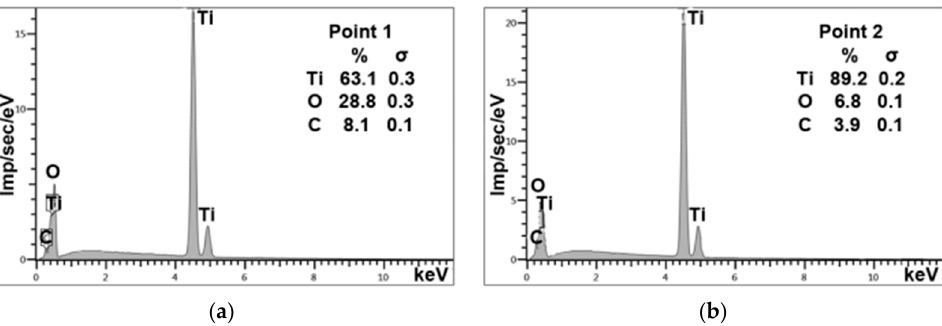
Figure 2. Legend of mapping the chemical elements Ti ( a ), O ( b ), and C ( c ) of the initial fraction of titanium hydride.